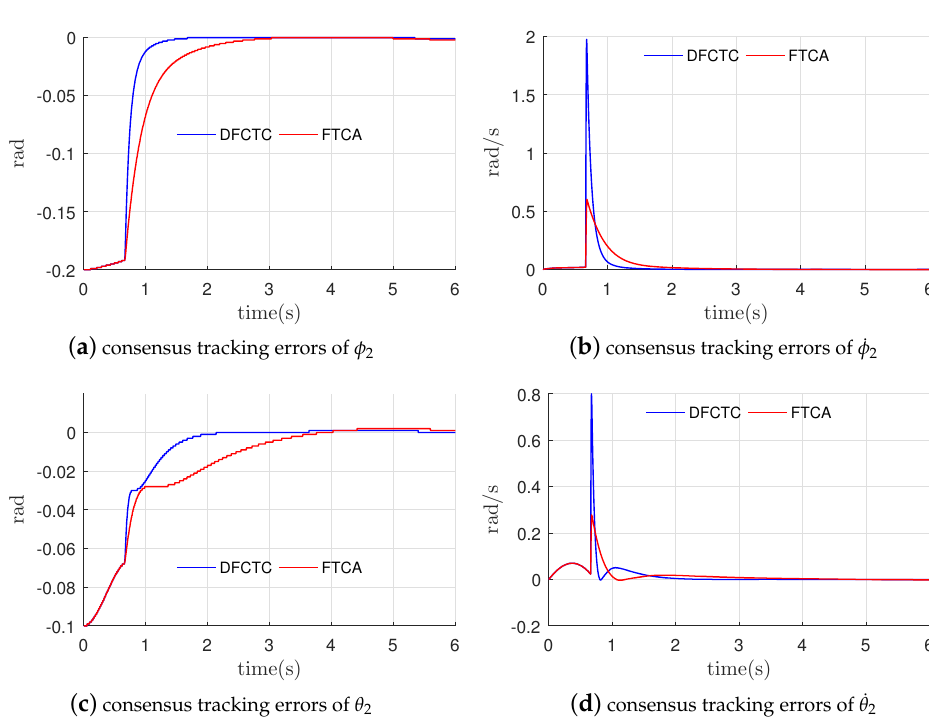
Figure 5. Consensus tracking errors for agent i = 1.